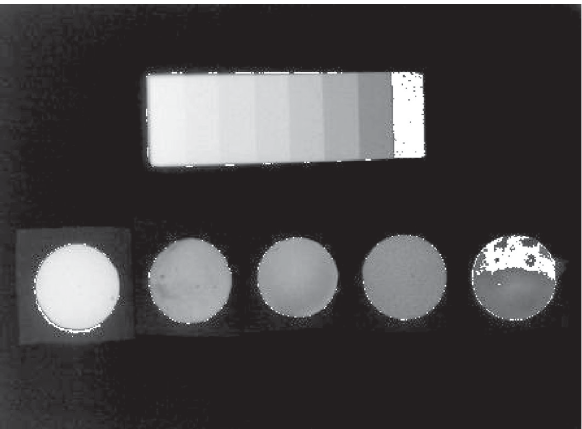
FIGURE 4- Radiograph showing the radiopacity of Sealapex and its equivalence to the aluminum step